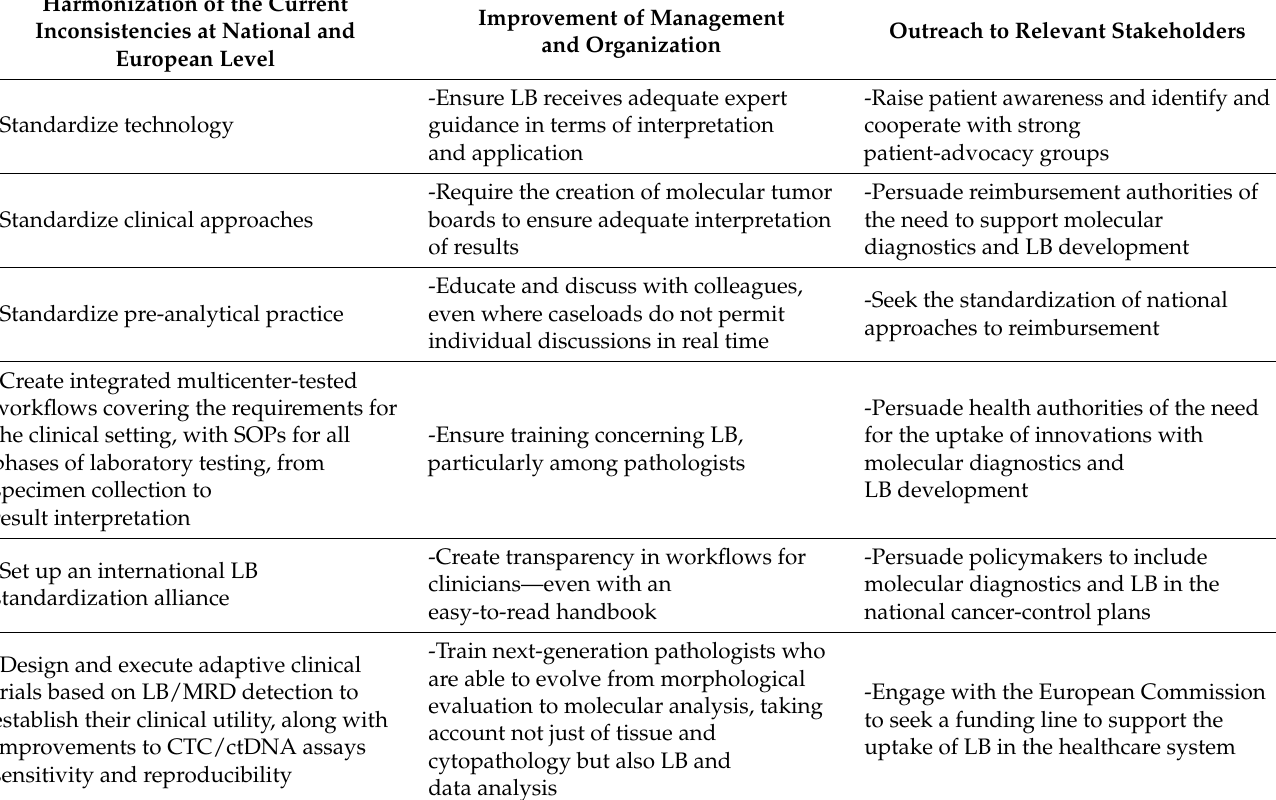
Table 2. Recommendations emerged from the roundtable grouped in three